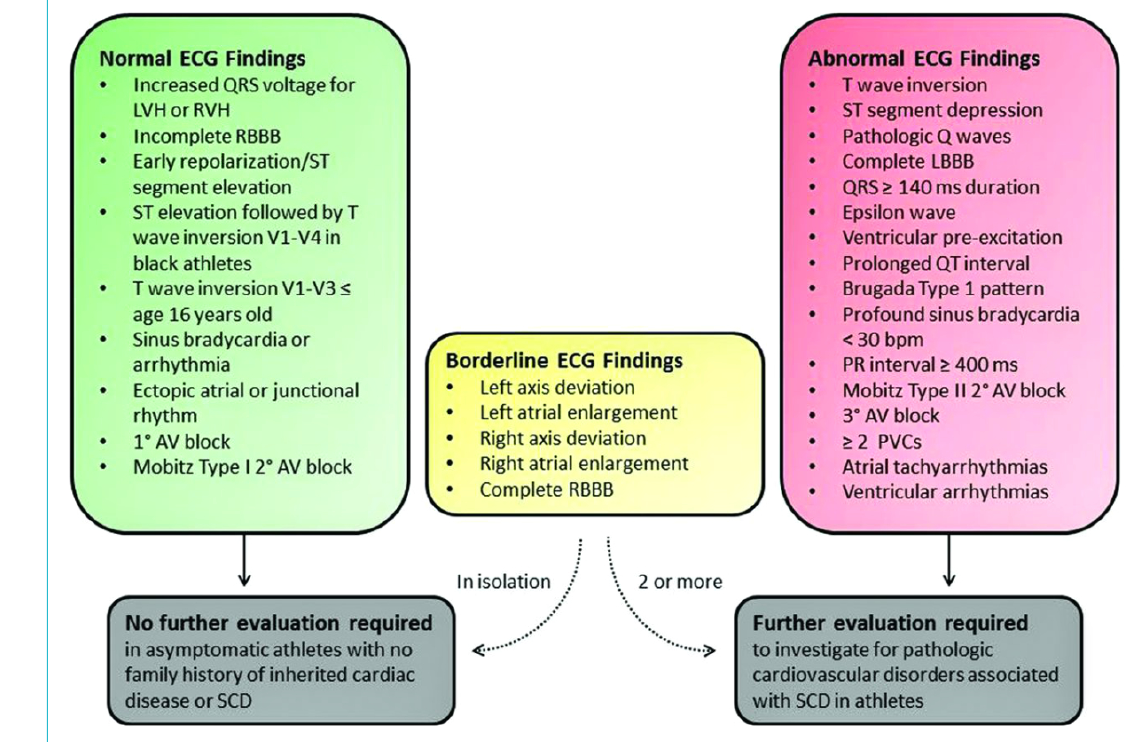
Figure 1: International consensus standards for ECG interpretation in athletes, reprinted with permission from: from: Drezner JA, Sharma S, Baggish A, Papadakis M, Wilson MG, Prutkin JM, et al. International criteria for electrocardiographic interpretation in athletes: